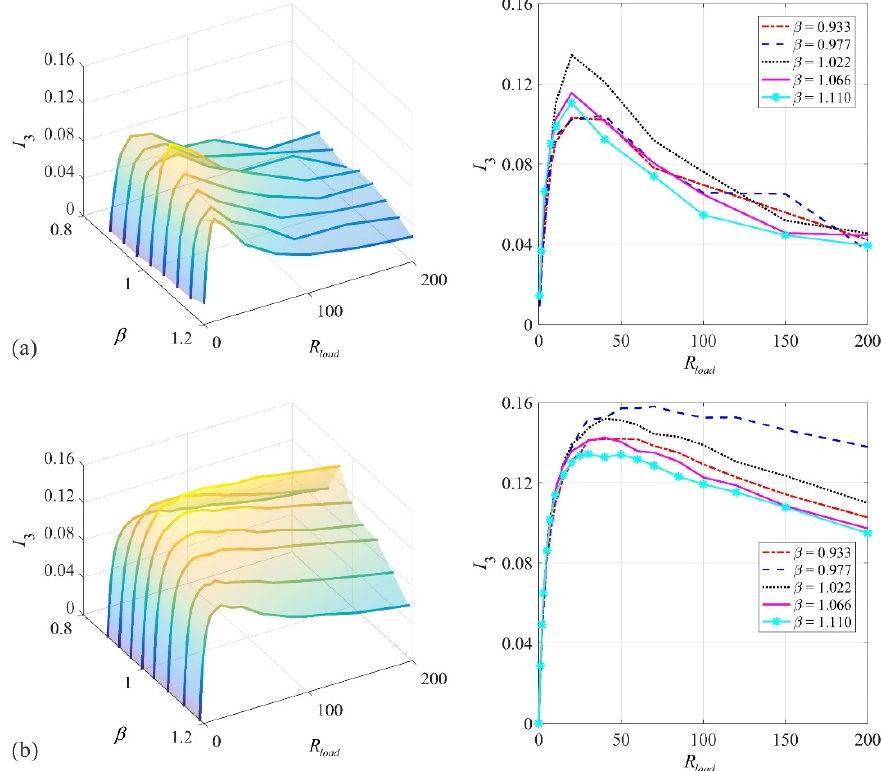
Figure 16. 3D and 2D plots of I 3 with µ = 0.050: ( a ) experimental result; ( b ) simulation result.